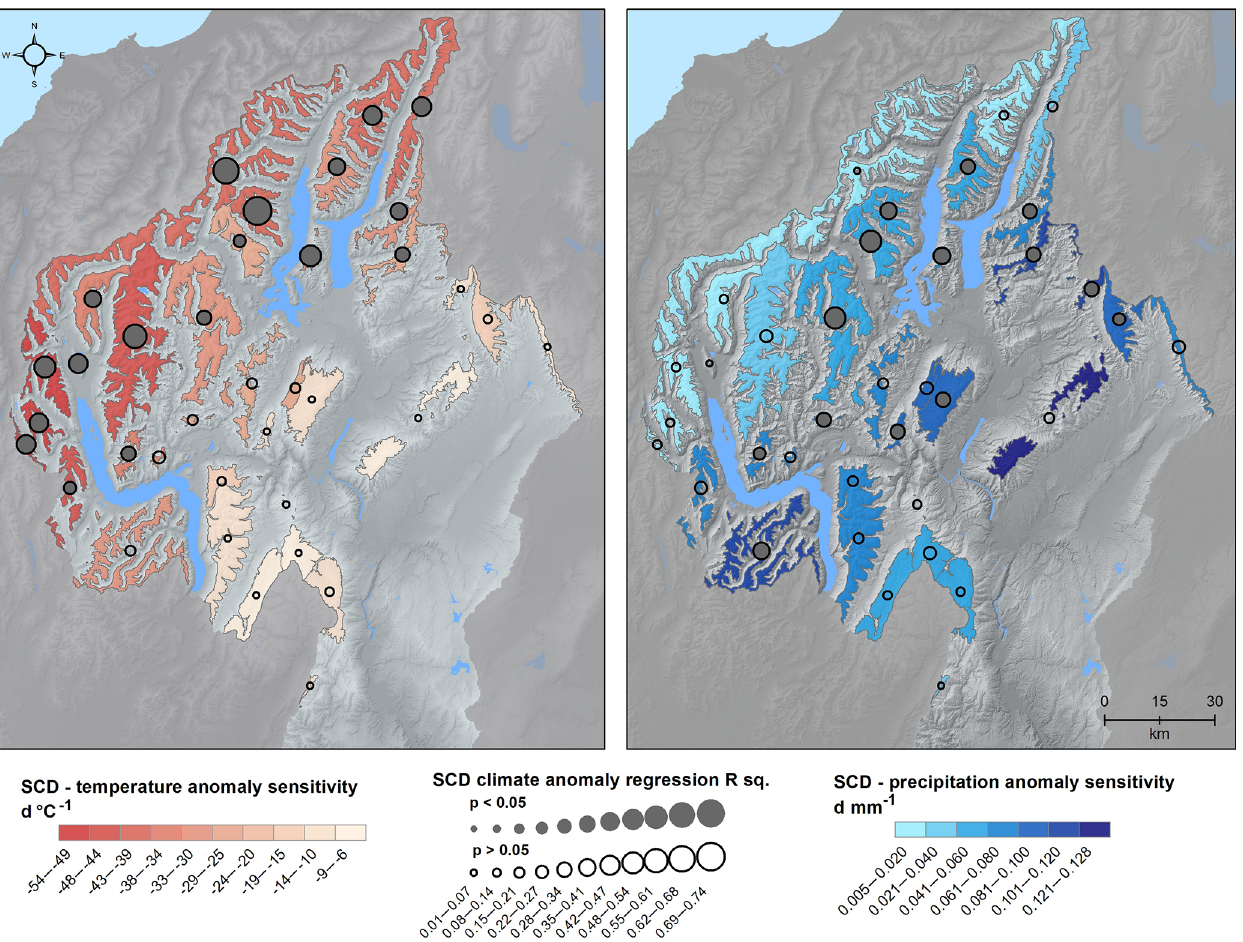
Figure 16. Spatial variability in the regression parameters of slope and R 2 between SCD anomaly and temperature and precipitation anoma- lies for each mountain range within the Clutha Catchment. Elevation and relief data from Columbus et al. (2011); lake outlines sourced from the LINZ Topographic